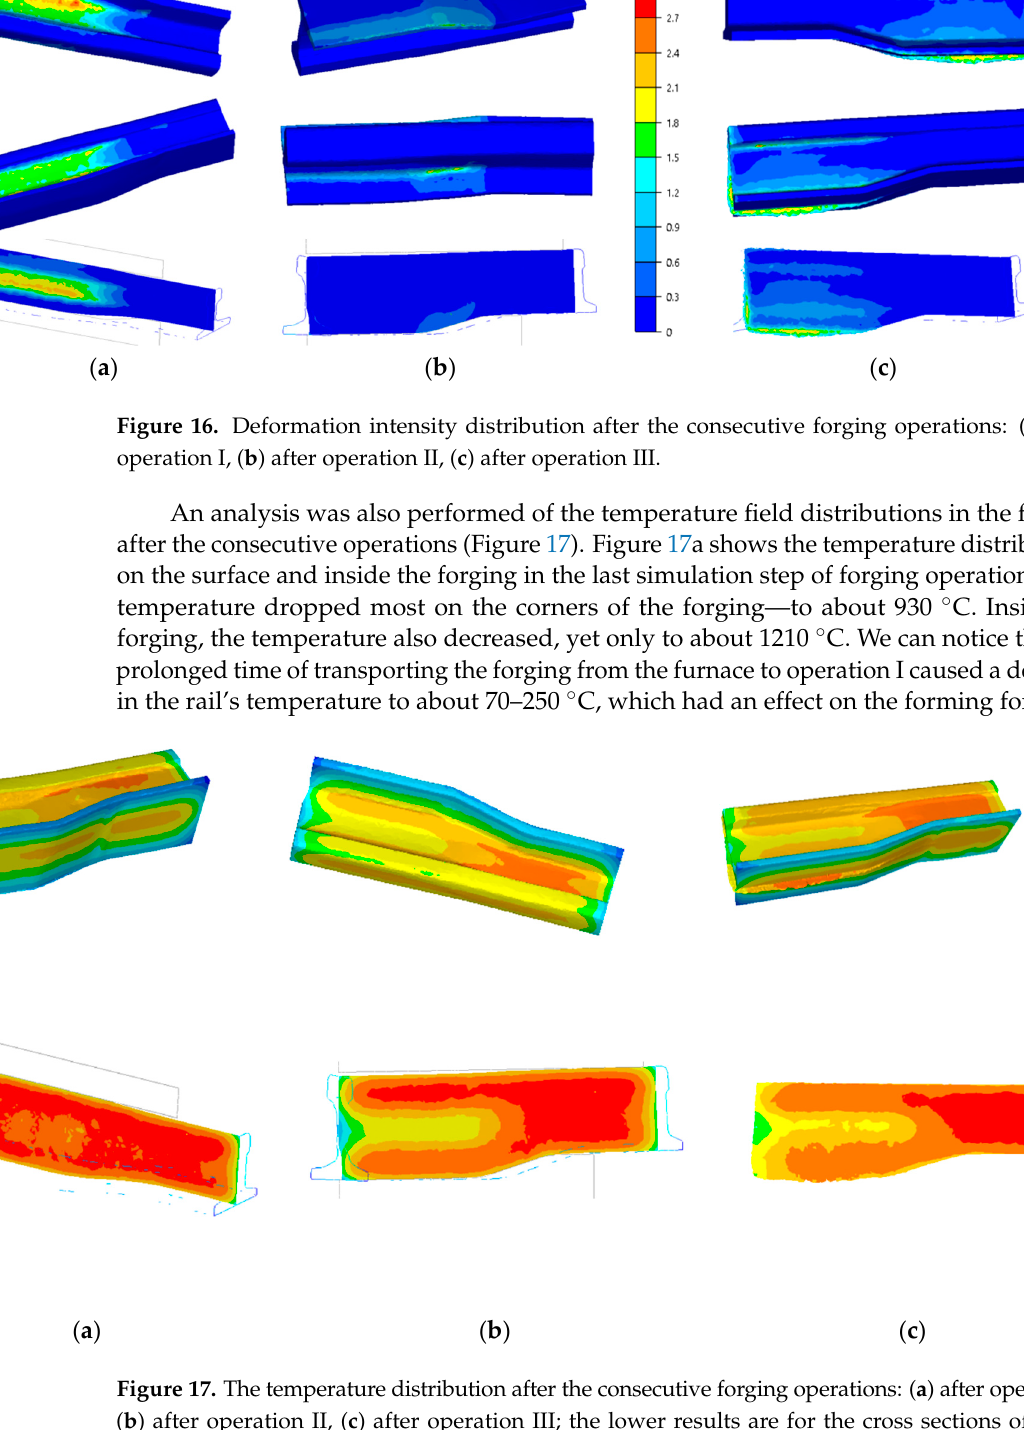
Figure 18. Distribution of deviations of the shape calculated from FEM from the nominal shape and dimensions from the CAD model. We can notice that the allowances for the trimming treatment are in the correct areas, the shape and dimensions of the rails correlate quite well, and the determined deviations are at the level of 0–1.5 mm, that is, they are within the assumed tolerance field. Figure 19 shows a diagram of the forging forces in all the operations of forming a needle rail type 60E1A6 with a shortened reforging length. As was expected, the highest forging force value, equaling about 2500 t, occurred in the last forging operation. The rail underwent significant cooling during the preceding forging operations and transport— on the corners of the forging, the temperature at the entrance into operation III was lower by over 300 °C than the initial temperature (1280 °C). It was the larger contact area during forming in operation III, the prolonged times of transport and the formed flash that caused the deformation force in the last operation to increase almost three times compared to operation II.